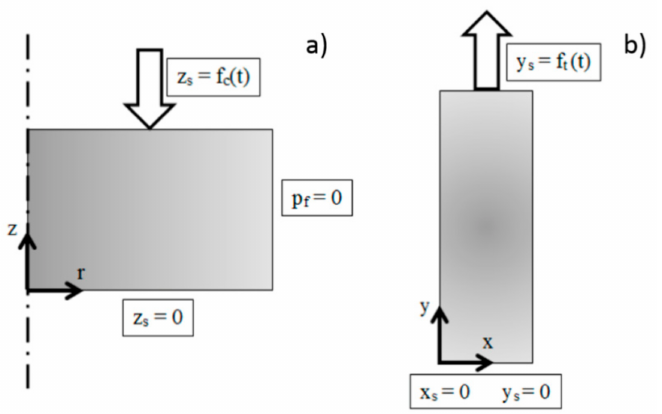
Figure 3. Representation of numerical model along with boundary conditions used for unconfined compression ( a ) and tension ( b ) simulations: ( a ) circular disk under unconfined compression is represented through 2D axial-symmetry. The fluid pressure (p f ) was set to 0 at the right boundary, a multiramp compressive load (f c (t)) was applied to the disk in the z direction (z s ) on the upper boundary, the movement in which was constrained at a lower boundary; ( b ) a 2D geometry was used to model the sample under tension. A multiramp tensile force (f t (t)) was applied to the upper boundary in the y direction (y s ), whereas the lower boundary was constrained in both the x s and y s directions.